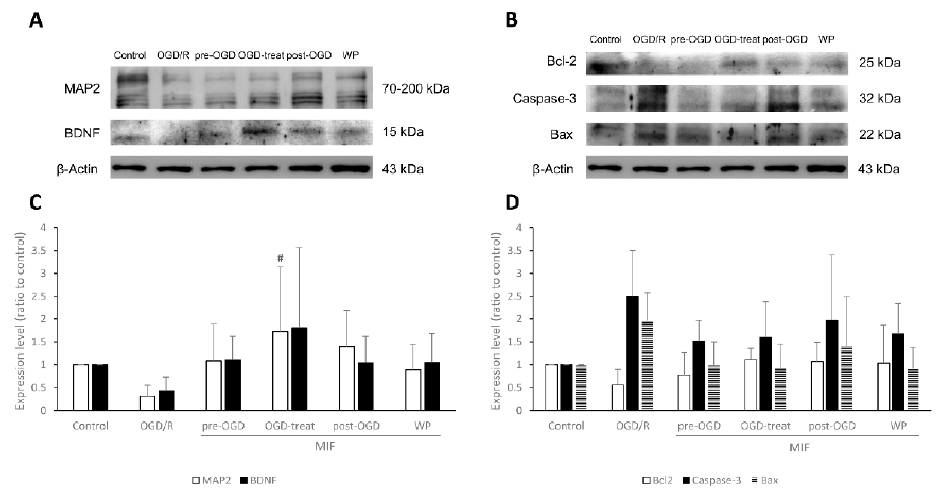
Figure 6. Western blot analysis of MAP2, BDNF, Bcl-2, Caspase-3, and Bax expression under control, OGD/R, and OGD/R conditions administered with MIF at different times. ( A , B ) Representative bands of each group in the Western blot; ( C , D ) the expression level of MAP2 was significantly higher in the OGD-treat group than in the OGD/R group. Mean ± SD values are presented. # p < 0.05 vs. OGD/R group. The differences among the groups were analyzed using one-way ANOVA followed by Tukey’s post hoc test (number of independent cell culture experiments ( n ): MAP2, n = 7; BDNF, n = 5; Bcl-2, n = 5; Caspase-3, n = 6; Bax, n = 5).